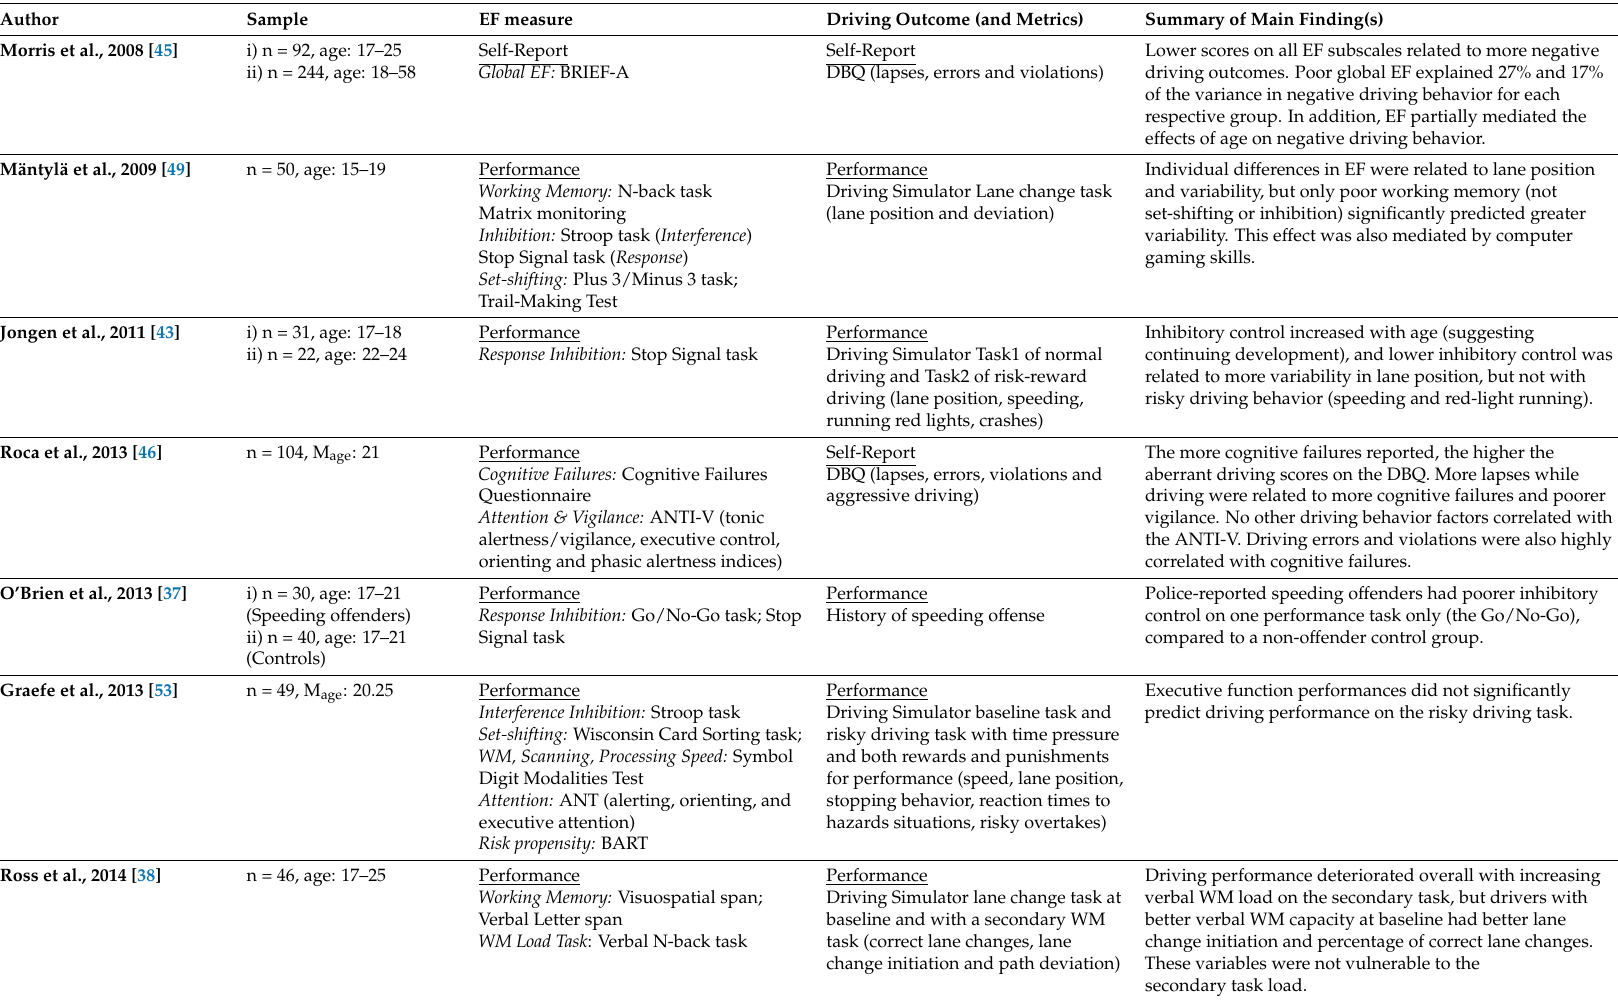
Table 1. Summary of research papers included in this